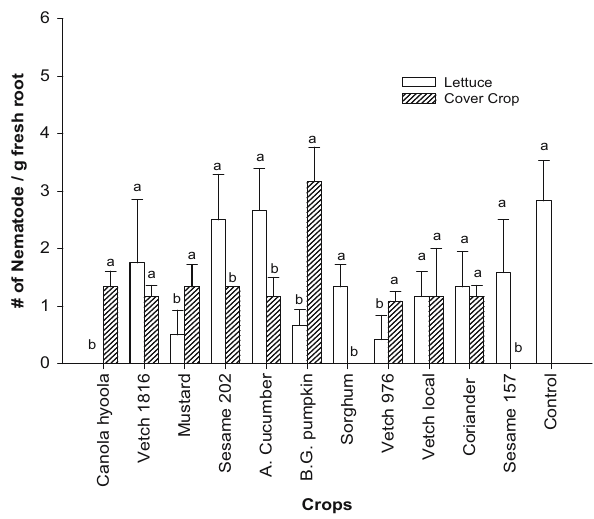
Figure 8: The total number of RKN juveniles per gram fresh root in the root systems of the host plant lettuce ( Lactuca sativa L. ) planted with 11 local non - host crops as trap plants. The standard deviation of the means is designated by the error bar for each mean. Means followed by the same letter are not signi fi cantly di ff erent ( SNK, P > 0.05 ) .